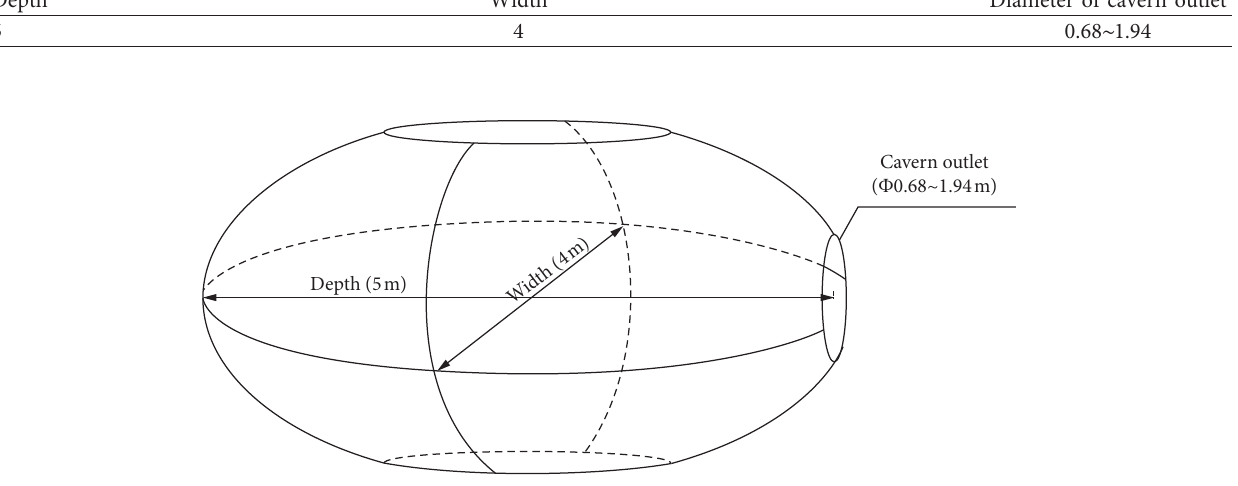
Figure 2: Sketch map of coal and outburst